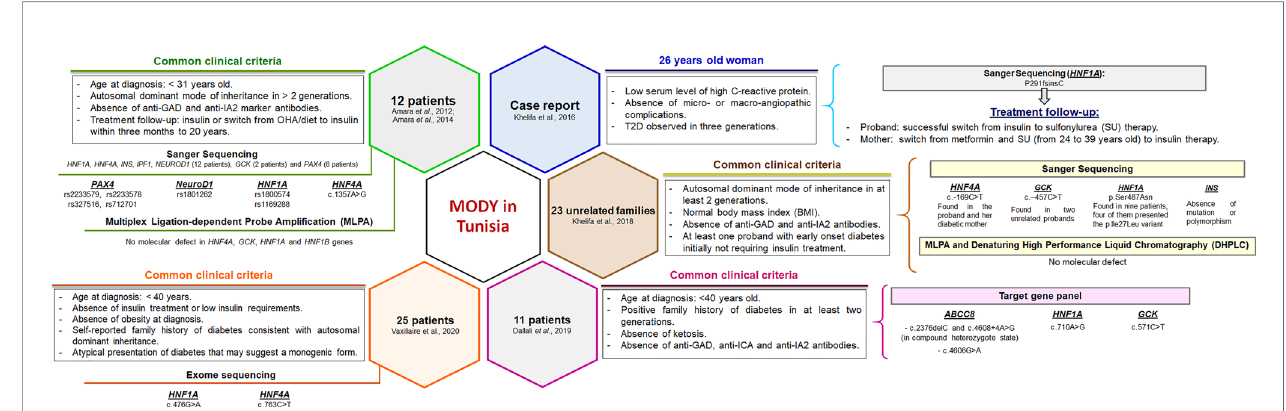
FIGURE 1 | Clinical and genetic characterization of Tunisian MODY patients reported in previous studies. The clinical and familial inclusion criteria were speci fi c for each study. Pathogenic variants and polymorphisms found in Tunisian patients were mainly reported in the most prevalent MODY genes. Functional studies have not been performed. OHA, oral hypoglycemic